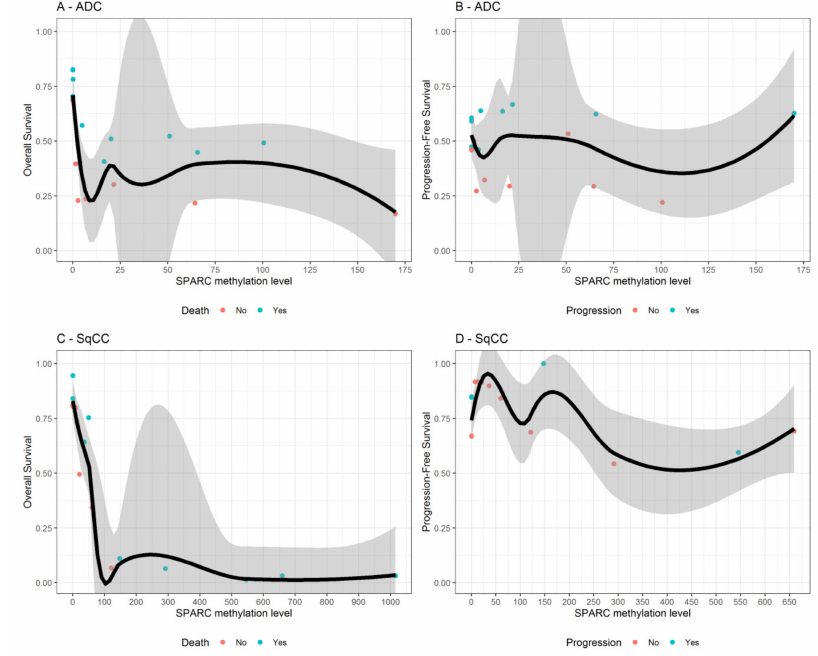
Figure 10. For NSCLC patients with early tumor stage only, variable dependence plots show the relationship between SPARC methylation levels and both the overall-survival and progression-free survival, estimated from Survival Random Forest, for patients with ADC (panels A and B ) and SqCC (panels C and D ), respectively. Individual cases are marked with blue (alive or censored) and red circles (events). Loess smooth curve with shaded 95% confidence band indicates decreasing survival with increasing SPARC methylation